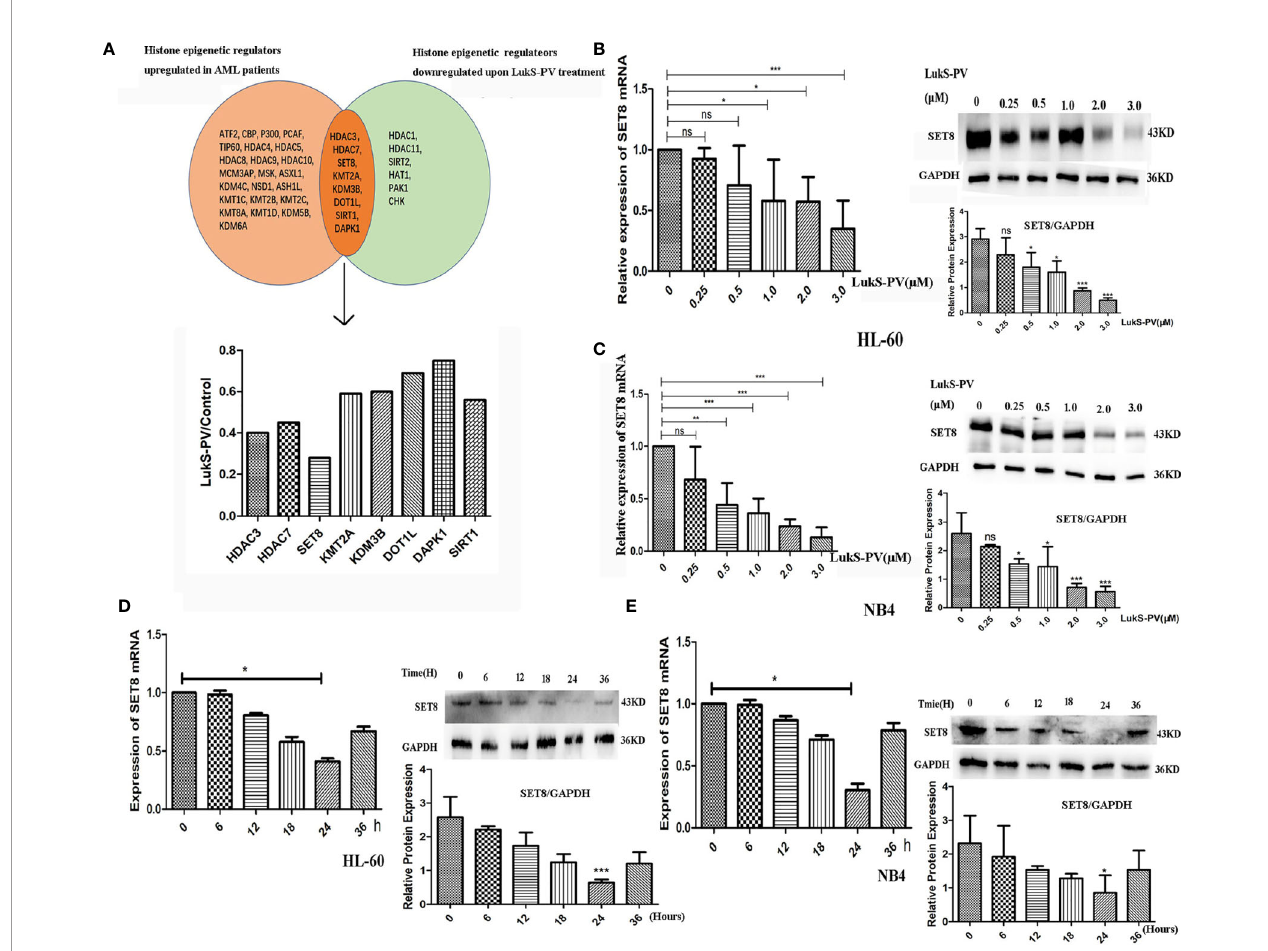
FIGURE 2 | SET8 is downregulated in acute myeloid leukemia (AML) cells after LukS-PV treatment. (A) Downregulated histone epigenetic regulators after LukS-PV treatment. (B) HL-60 and (C) NB4 cells were treated with LukS-PV at different concentrations, and SET8 mRNA and protein expression levels were determined by quantitative real-time PCR and Western blotting. (D) HL-60 and (E) NB4 cells were treated with 3.0 m M of LukS-PV at different timepoints, and SET8 mRNA and protein expression levels were determined by quantitative real-time PCR and Western blotting. ns, not signi fi cant; *p < 0.05; **p < 0.01; ***p <